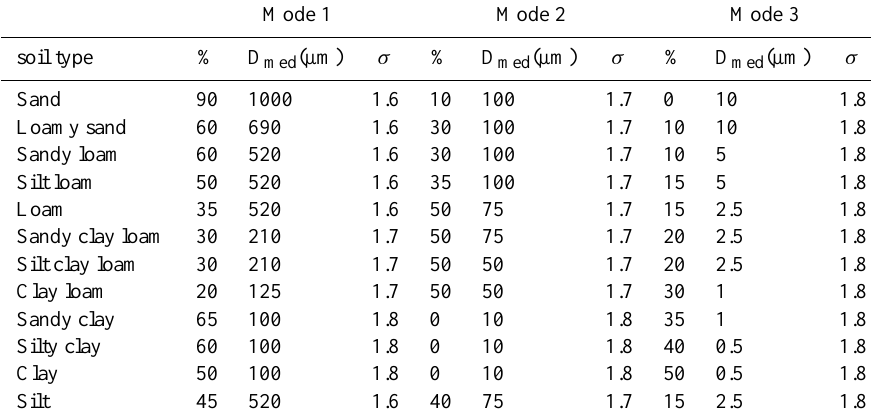
Table 2. The 12 basic USDA soil texture indices and corresponding soil aggregate size distribution parameters. Mode 1 Mode 2 Mode 3 soil